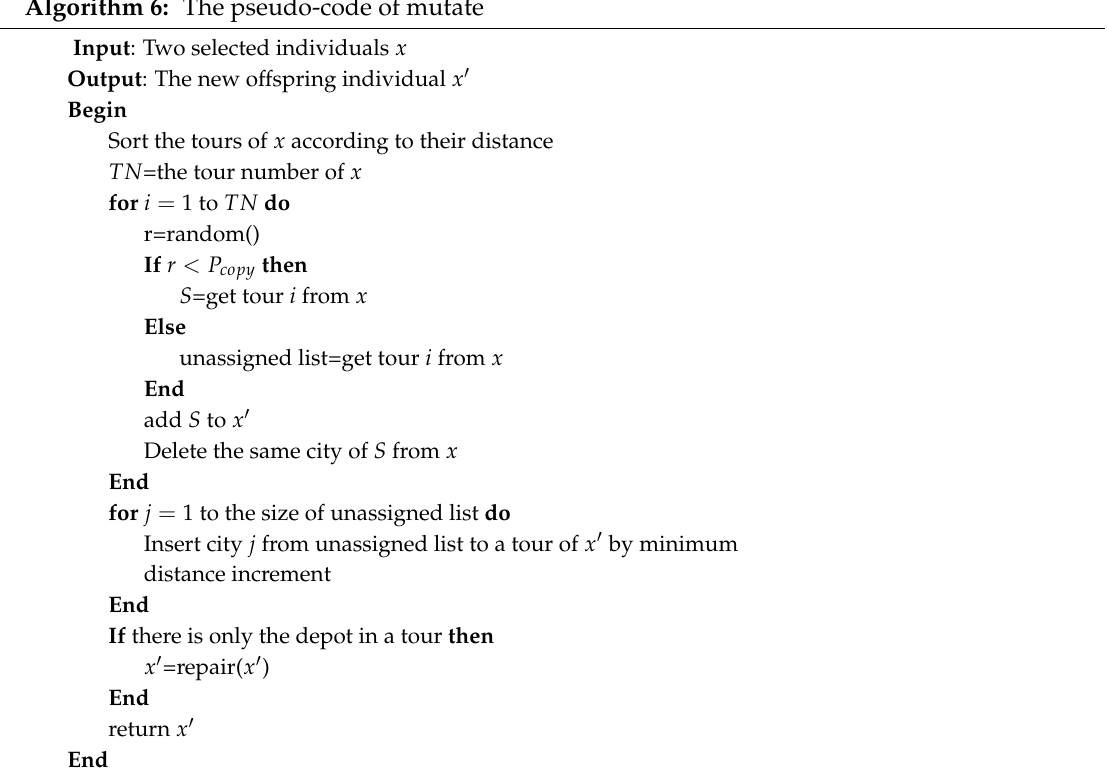
Algorithm 6: The pseudo-code of